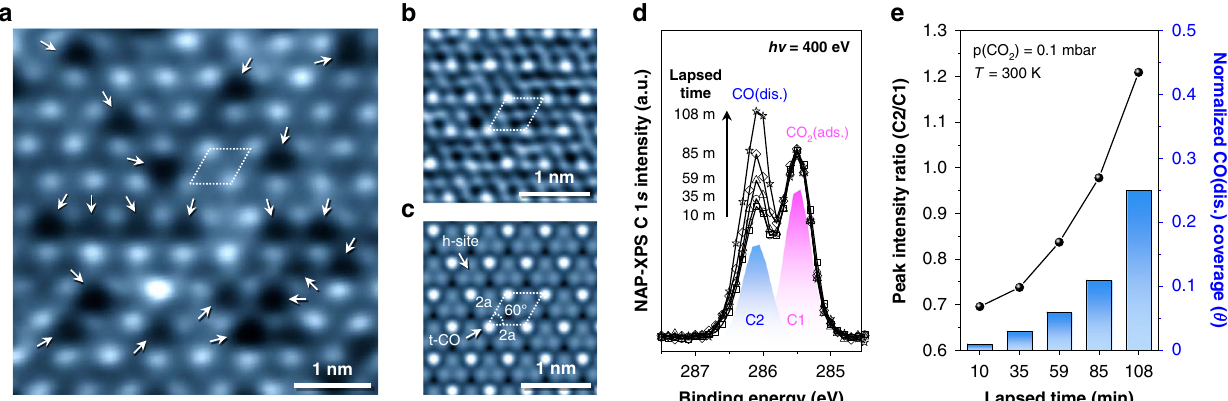
Fig. 3 Direct observations of dissociated CO and O adsorptions at the CO 2 /Rh interface. a − c Atom-resolved adsorption structure analysis during the CO 2 dissociation over Rh(111) surface. A representative real-time observation result using NAP-STM at 0.1 mbar CO 2 ( V t = 0.25 V; I t = 0.17 nA) ( a ), their narrow-scale image ( V t = 0.21 V; I t = 0.30 nA) ( b ) and the DFT-simulated STM image of (2 × 2)-CO adsorption structure on the Rh(111) surface ( c ). Indicated arrows and corners of the parallelogram on the images are corresponding to dissociated O* and CO*, respectively. d , e Time-lapsed spectroscopic measurement results of dissociated CO adsorptions on the Rh(111) surface using NAP-XPS ( h ν = 400 eV). Recorded C 1 s core-level spectra on the Rh(111) surface ( d ) and peak intensity ratio histogram analysis plots for the measured C 1 s spectra ( e ) under 0.1 mbar CO 2 environment. Each peak intensity of C2 was normalized to the of fi xed C1 ratio in C 1 s core-level spectrum. The assigned CO (dis.) and CO 2 (ads.) peaks are labeled as C2 (blue) and C1 (magenta), respectively. All spectral interpretation procedures were identically carried out before and after normalization of C 1 s core-level NAP-XP spectra (Supplementary Fig.